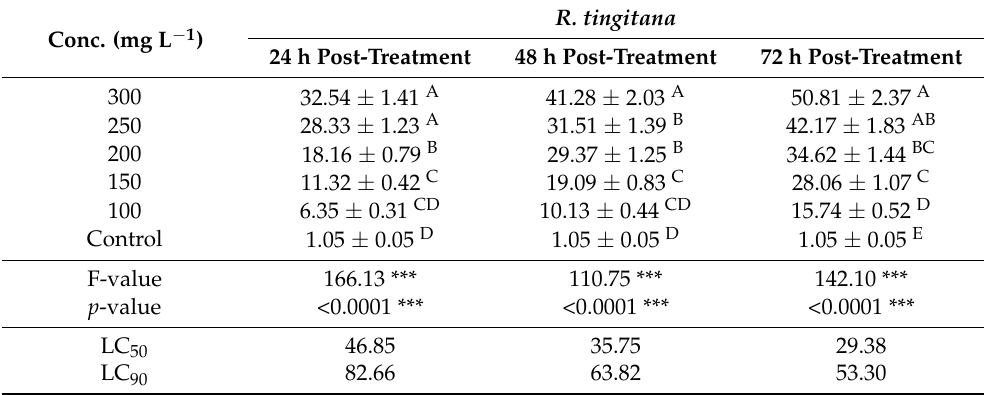
Table 5. Larvicidal effect of the methanol extract from the aerial parts of R. tingitana on 3rd larval instar of A. aegypti